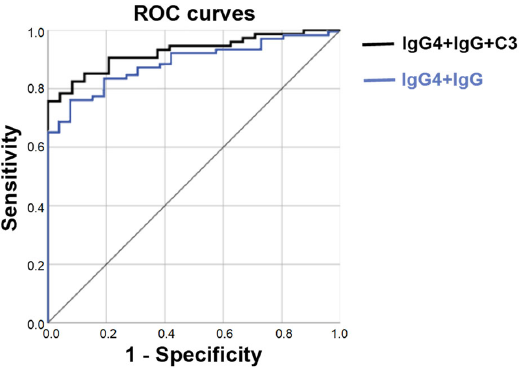
Figure 3. ROC curves of different prediction models. The black line represents the ROC curve of IgG4+IgG+C3 (AUC = 0.926), and the blue line represents the ROC curve of IgG4+IgG (AUC = 0.892). Since the AUC of IgG4+IgG+C3 in peripheral blood was the largest, IgG4, IgG, and